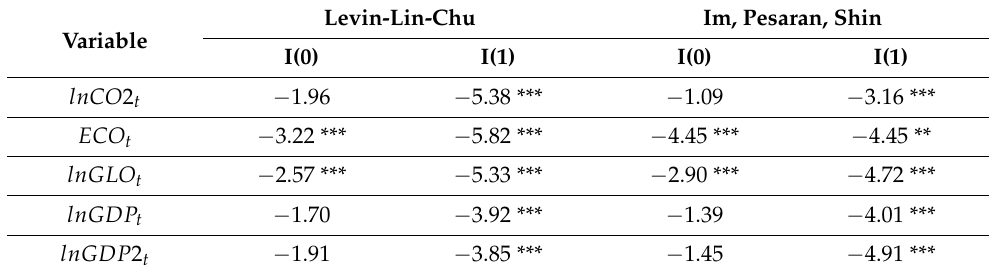
Table 3. Unit root tests.